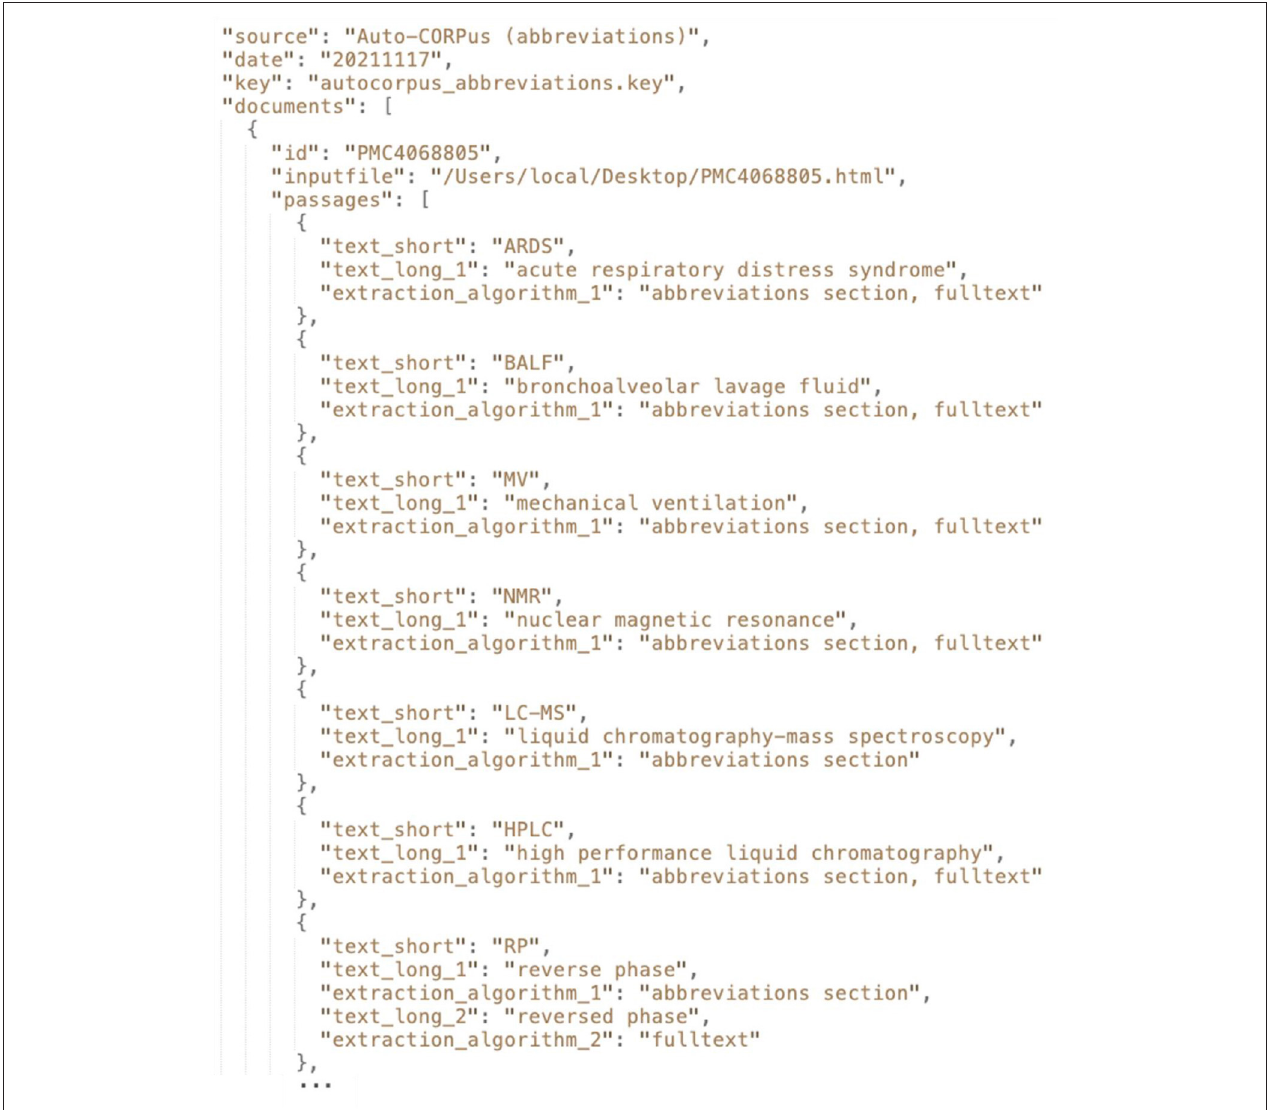
FIGURE 2 | An extract from the Auto-CORPus abbreviations JSON created from the PMC4068805 full-text HTML file. For each abbreviation the corresponding long form definition is given along with the algorithm(s) used to detect the abbreviation. Most of the abbreviations shown were independently identified in both the full-text and in the abbreviations section of the publication. A variation in the definition of “RP” was detected: in the abbreviations section this was defined as “reverse phase,” however in the full-text this was defined as “reversed phase.” The “autocorpus_abbreviations.key” file describes the contents of the abbreviations JSON file (https://